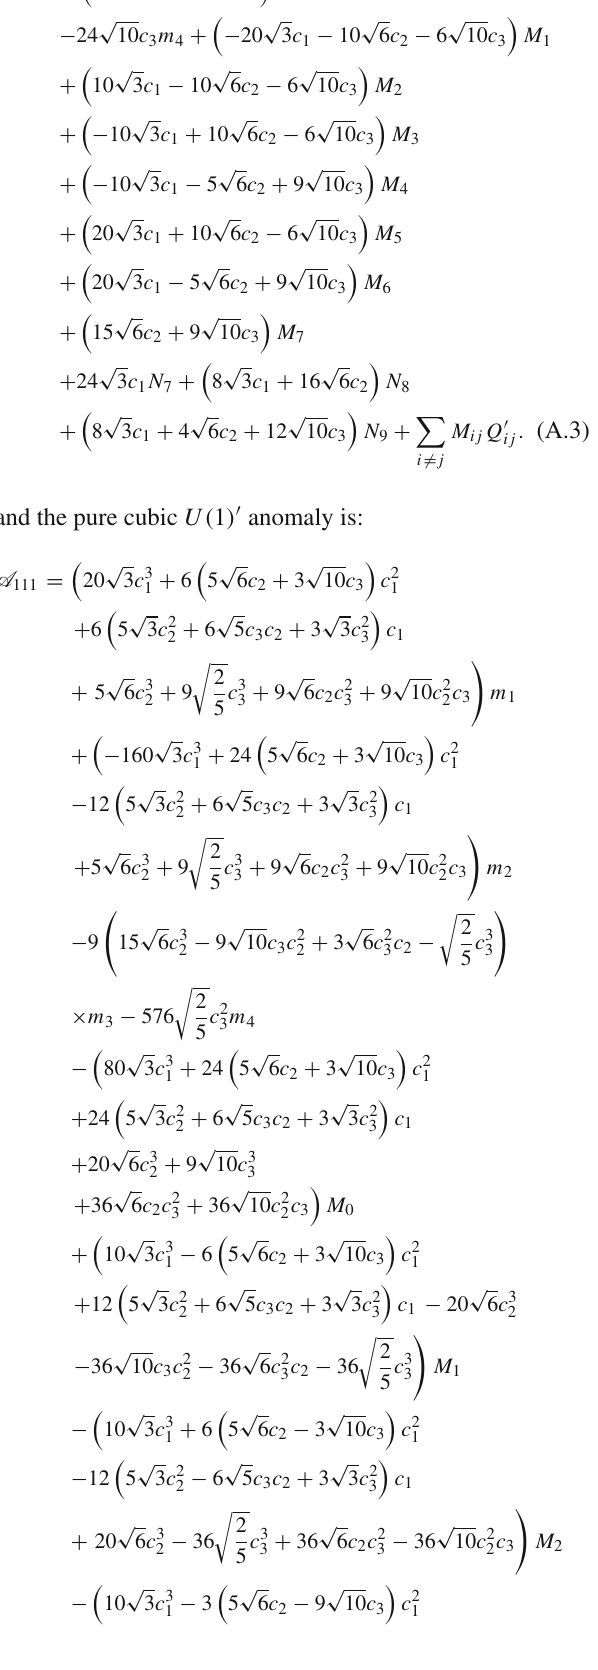
Table 9 Singlets charges of Class A